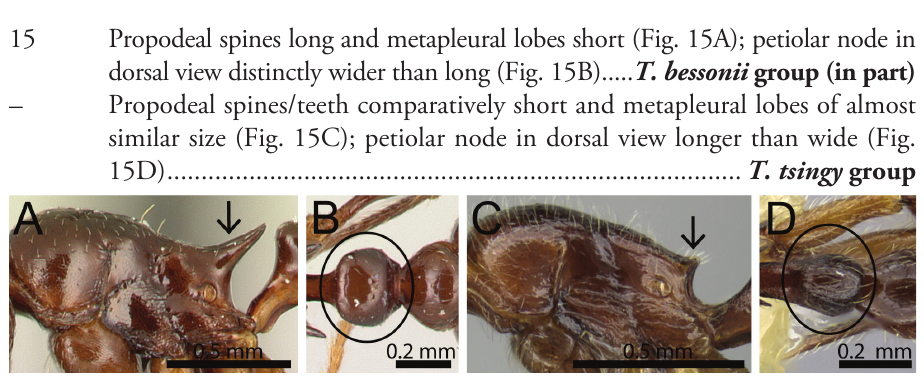
Figure 15. Mesosoma in profile (black arrows indicating propodeal spines/teeth) and petiole in dorsal view (within black ellipse). A, B T. malagasy (CASENT0449550) C, D T. tyrion (CASENT0249085). 16 Mandibles always unsculptured, smooth, shining (Fig. 16A, B); waist seg- ments always without long, erect to suberect pilosity (Fig. 16E, F) ...............